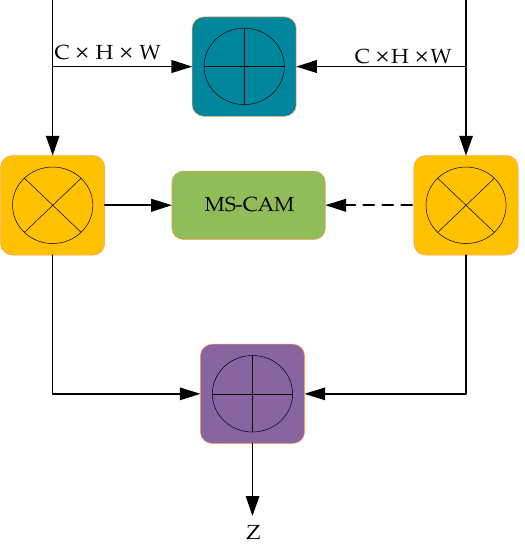
Figure 13. Structure of the AFF attention mechanism.